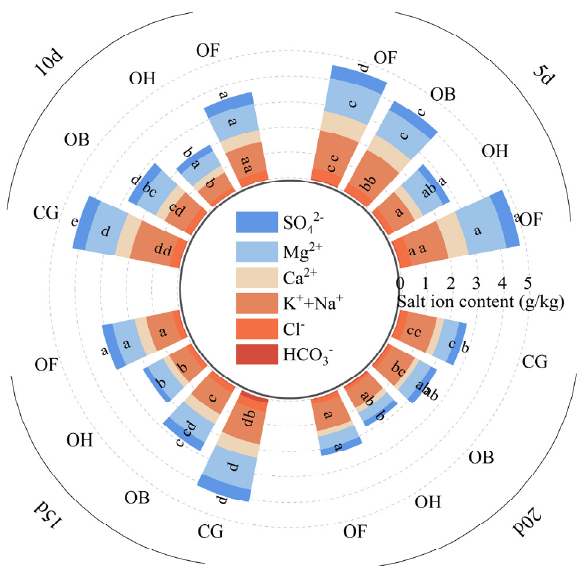
Figure 5. Variation of salt ion content in leachate with leaching time. Different lowercase letters at the same time indicated significant differences among different treatments ( p < 0.05).